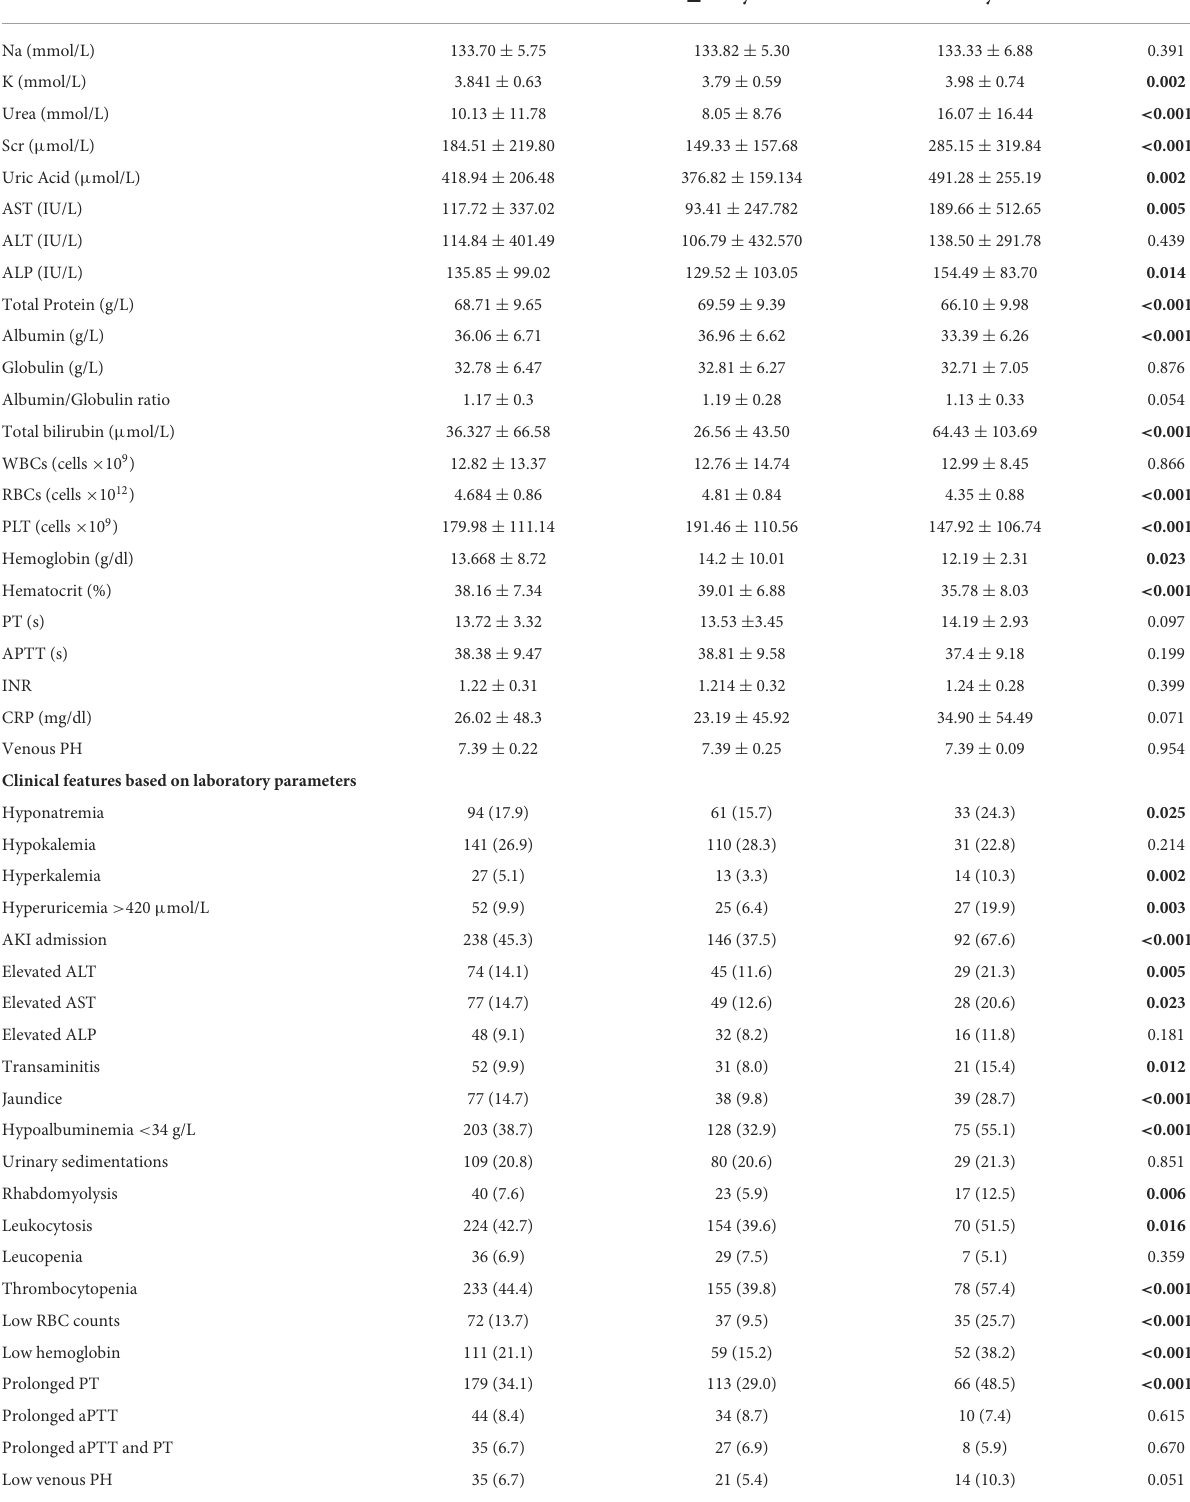
TABLE 3 Comparison of clinico-laboratory characteristics (at baseline) between patients with and without prolonged